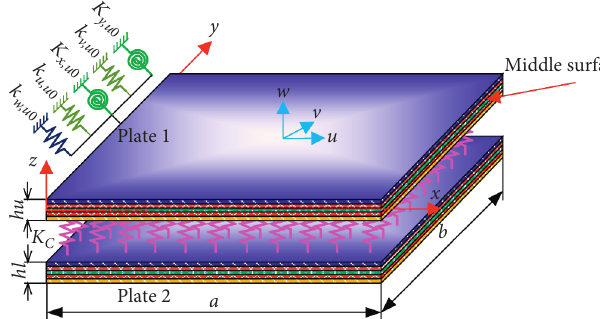
Figure 1: Model of LCDPS (laminated composite double-plate system) with general boundary